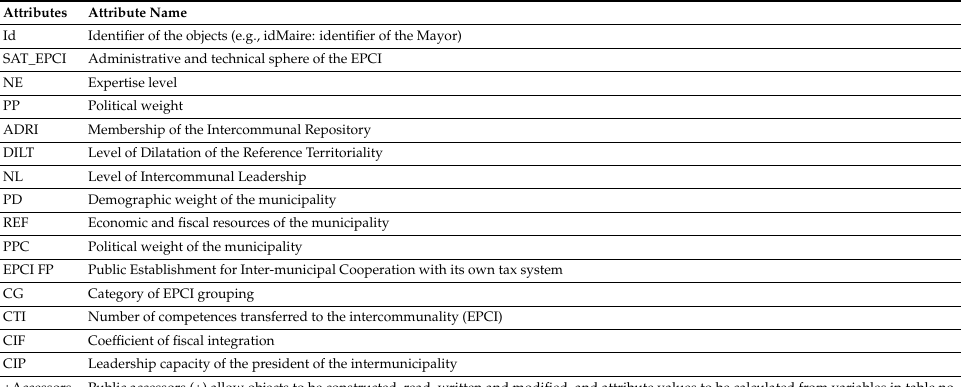
Table 5. Intercommunality case attributes